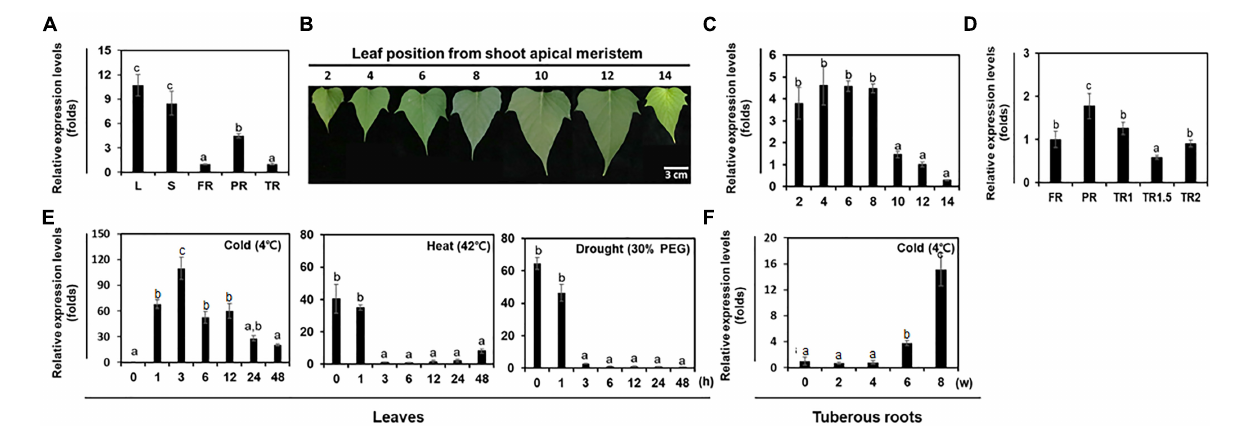
FIGURE 2 | Analysis of the expression levels of IbFAD8 in sweetpotato. (A) Expression levels of IbFAD8 in different tissues of sweetpotato plants. The Ubiquitin gene was used as an internal control for the normalization of IbFAD8 expression levels. L, leaves; S, stems; FR, fibrous roots; PR, pencil roots; TR, tuberous roots. (B) Position-dependent leaf development in sweetpotato plants. Images show representative leaves at each position from the shoot apical meristem. (C) Transcript levels of IbFAD8 in leaves at different positions on the stem. (D) Expression levels of IbFAD8 in sweetpotato tuberous roots at different developmental stages. FR, fibrous roots; PR, pencil roots; TR1, tuberous roots (diameter: 1–1.5 cm); TR1.5, tuberous roots (diameter: 1.5–2 cm); TR2, tuberous roots (diameter > 2 cm). (E) Transcript levels of IbFAD8 in sweetpotato leaves and (F) tuberous roots in response to various abiotic stresses. The third and fourth leaves from the top of sweetpotato plants were treated with cold (4 ◦ C) and heat (42 ◦ C) stresses, and IbFAD8 expression was analyzed by qRT-PCR. To analyze the effects of drought stress, the detached third leaf was placed in a 1.5-mL microfuge tube containing 30% polyethylene glycol (PEG 6000). Tuberous roots were stored at 4 ◦ C for 6 weeks to investigate IbFAD8 expression levels. All the experiments were conducted three times with 3 individual tissues for each replicate. h, hours; w, weeks. Different lowercase letters indicate significant differences ( p < 0.05; one-way ANOVA, followed by Tukey’s HSD post hoc test).